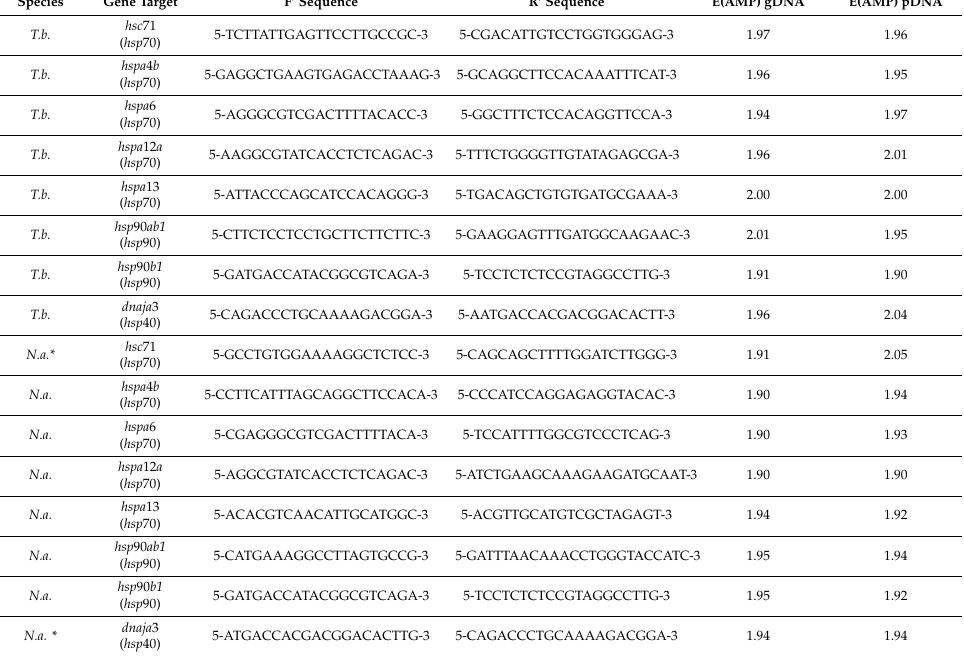
Table 2. Quantitative-PCR primers and amplification e ffi ciencies E (AMP) given for genomic and plasmid DNA. Primers with * were tested with DMSO additives to reduce suspected secondary structure